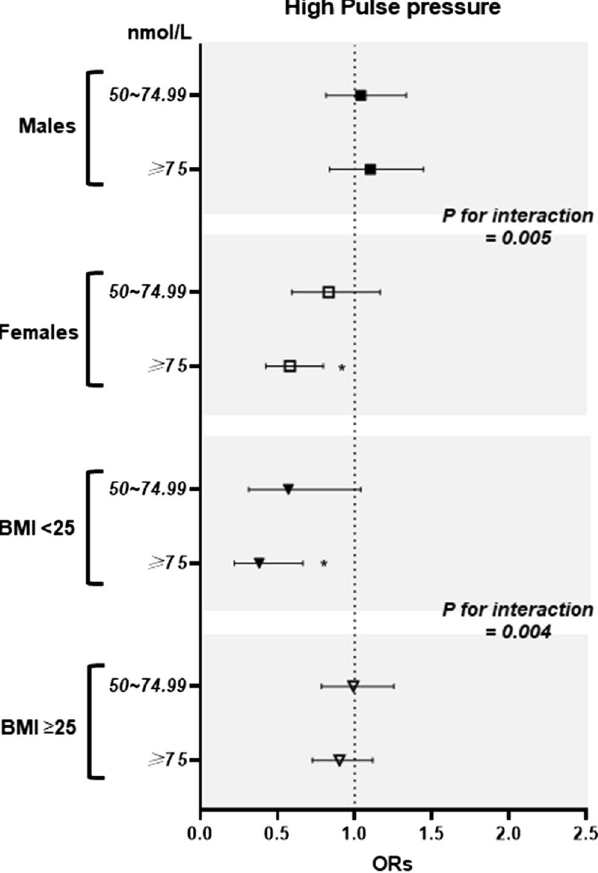
Figure 2. Multiple logistic regression of high pulse pressure with total 25(OH)D concentrations in the subgroups by sex and BMI. * p -trend < 0.05 considered significant. Adjusted for age, sex, race/ethnicity, education, season of examination, physical activity, alcohol consumption, smoking status, dietary covariates (intakes of total energy, potassium, calcium, magnesium, and sodium), height, weight, and